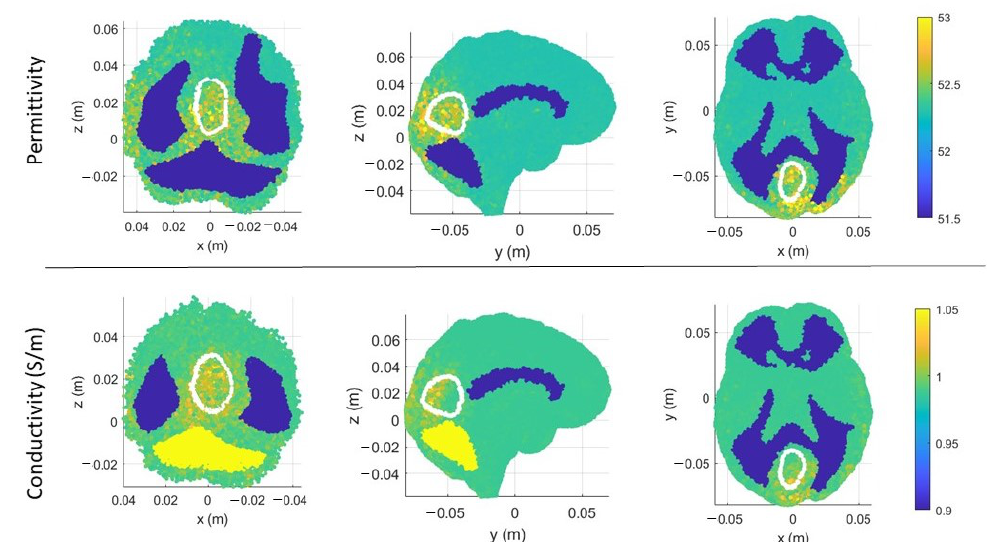
Figure 7. CSI algorithm results with the standard discretization. Shape, position, and dielectric property values of the stroke identified by the CSI algorithm after 100 iterations. On the first row, three different views of the permittivity, and on the second row, three different views of the conductivity. The perimeter of the expected stroke shape is shown in white.